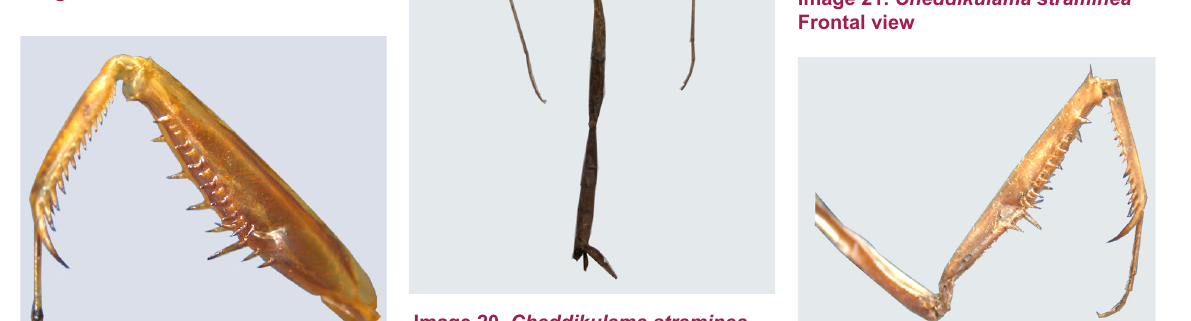
Image 18. Hierodula ventralis Fore coxa